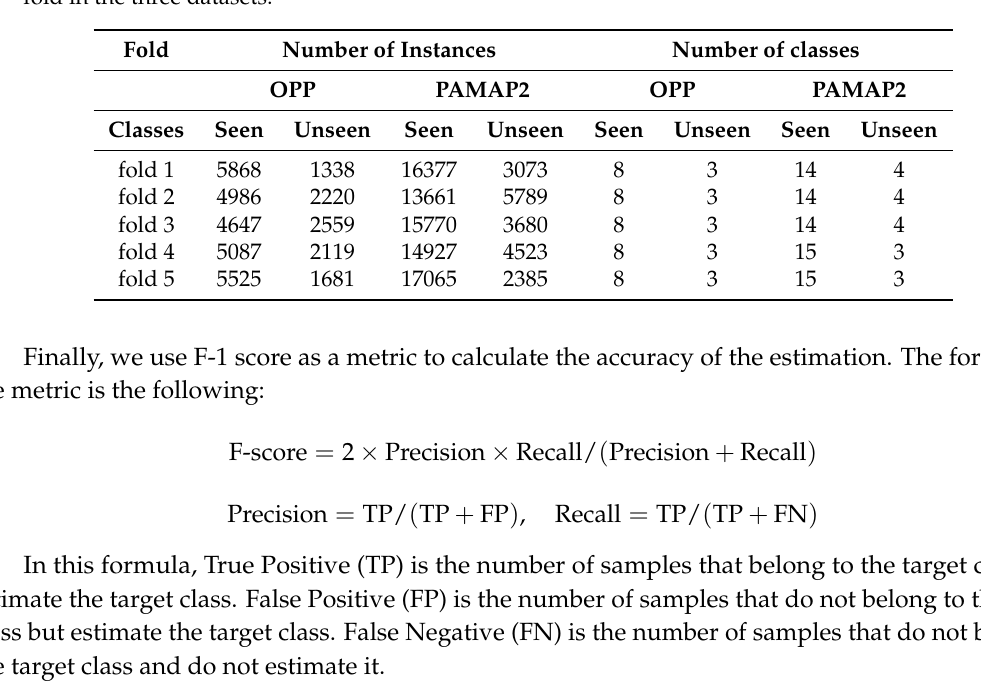
Table 5. Statistics on the number of instances and classes that belong to seen and unseen classes in each fold in the three